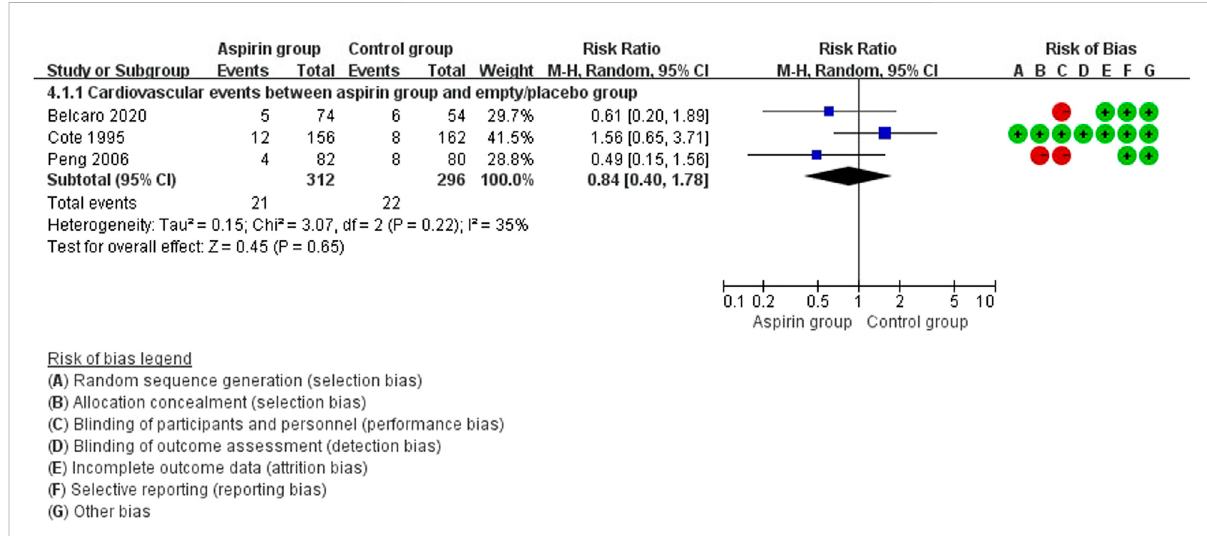
FIGURE 4 Forest plot of cardiovascular events between the aspirin group and the control group.